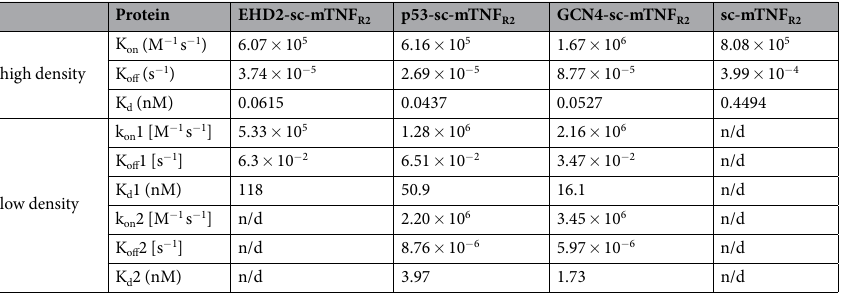
Table 2. QCM affinity measurements of oligomeric TNF